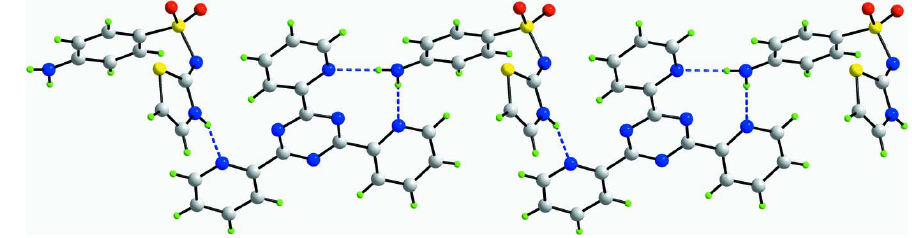
Figure 2 Supramolecular chains aligned along the [0 1 - 1] direction in (I) sustained by N—H···N hydrogen bonds which are shown as blue dashed lines.